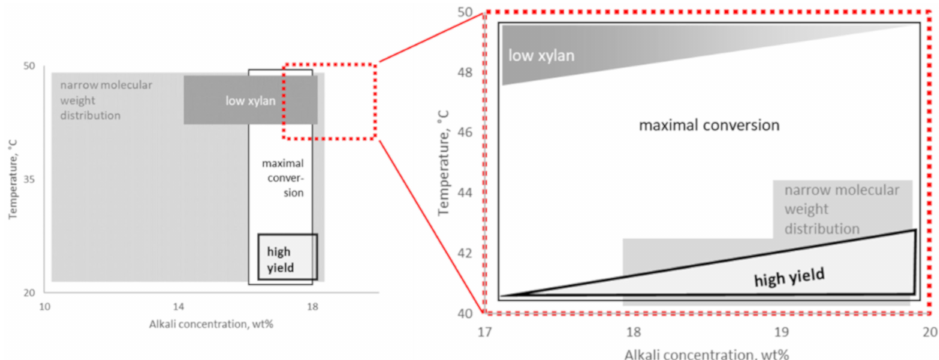
Figure 4. Trends for the key parameters of yield, xylan content, conversion to alkali cellulose and molecularweightdistributionfordi ff erentalkalineextractionsettingsofdissolvingpulp. Theillustration of the wide span of settings to the left is according to Fechter et al. [12].